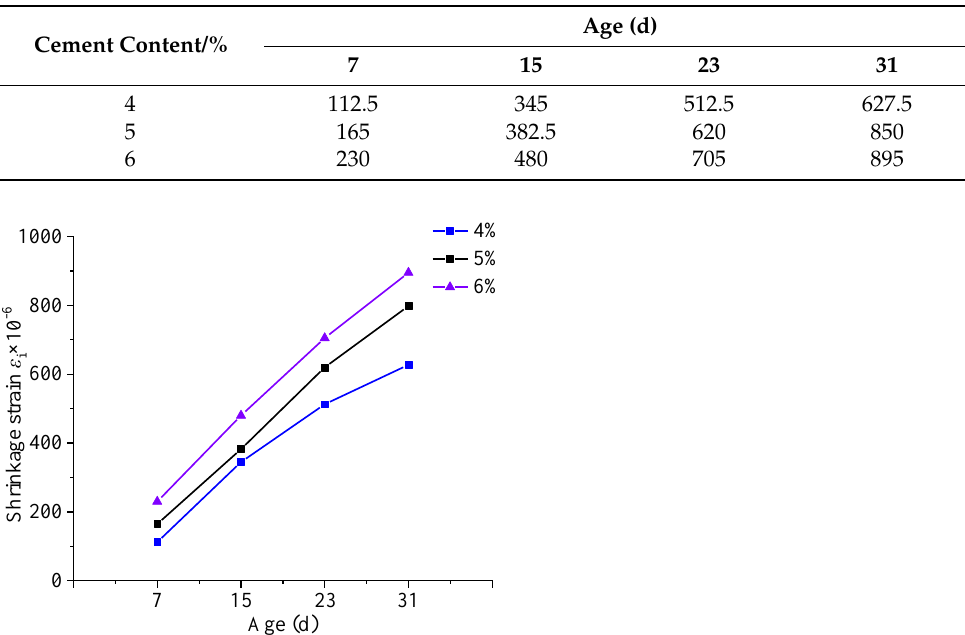
Figure 18. Freeze–thaw compressive strength loss diagram. Table 13. Dry shrinkage strain value of cement stabilized gangue ( × 10 − 6 ).